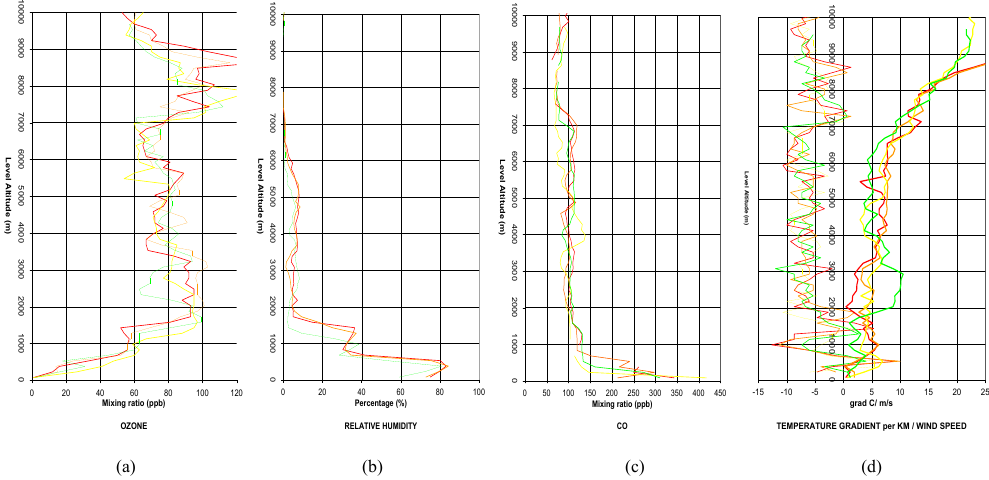
Fig. 6. (a) Vertical profiles of summer (JJA) ozone over the eastern Mediterranean airport of Tel Aviv during the 3-day high ozone period in the lower troposphere, 30 July–1 August 2003 (Profiles: MD20030730084 (red), MA20030731024 (orange), MD20030731102 (yellow), MA20030801012 (green)); (b) same as (a) but for relative humidity; (c) same as (a) but for carbon monoxide (CO); (d) (left), same as (a) but for temperature gradient per km; (right), same as (a) but for wind speed.